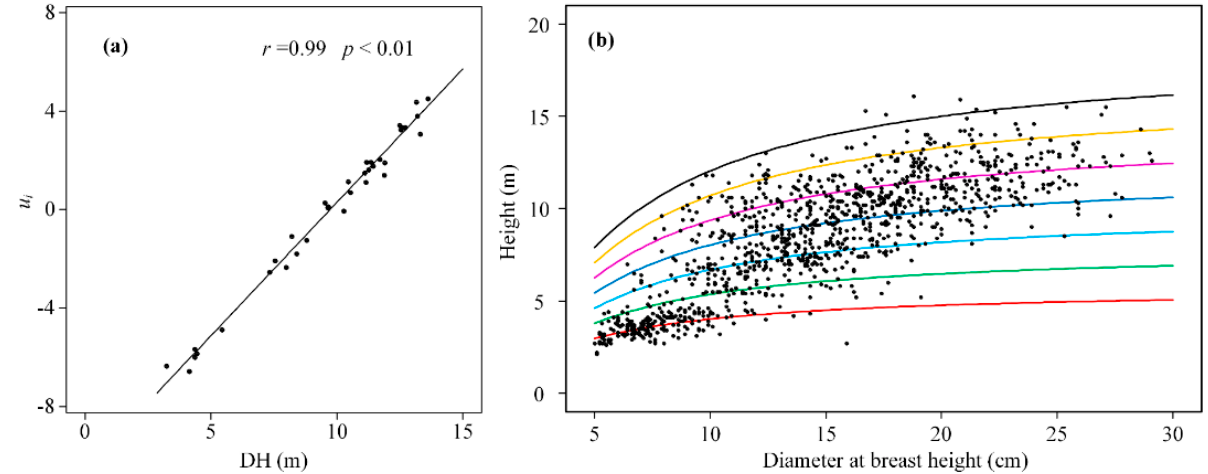
Figure 5. The Pearson correlation between DH and the estimated random-effects of the basic mixed-effects model ( a ), and effects of DH on H-D relationships ( b ). The fitted H-D curves in the figure ( b ) were based on the fixed prediction of the generalized mixed-effects model. The colorful lines from the bottom to the top indicate DH values from 4 m ( red ) to 16 m